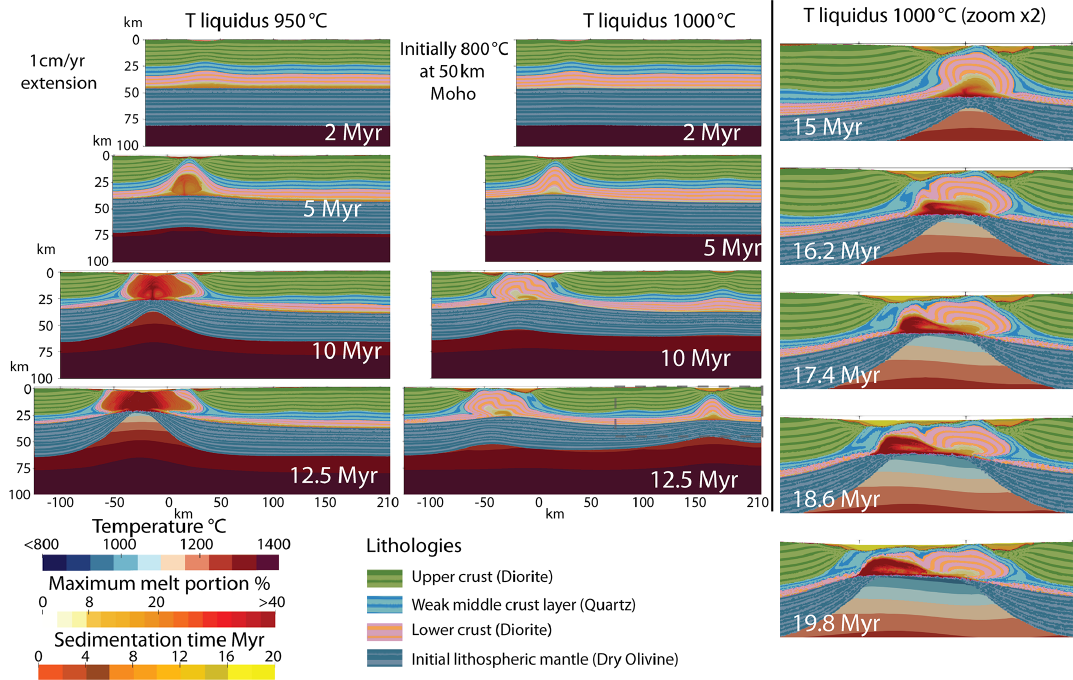
Figure 15. Snapshots of the numerical experiments with two different liquidus temperatures (950 and 1000 ◦ C) from 2 to 12.5Ma.